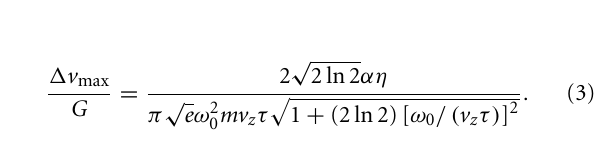
FIGURE 4 | Deflection efficiency ( (cid:3) v max / G ) vs. ω 0 . The solid line represents the deflection efficiency in Equation (3). The filled triangles are the experimental data. The dashed line represents the deflection efficiency with the experimental conditions in Stapelfeldt et al. [3], and the circle is the result from Stapelfeldt et al.